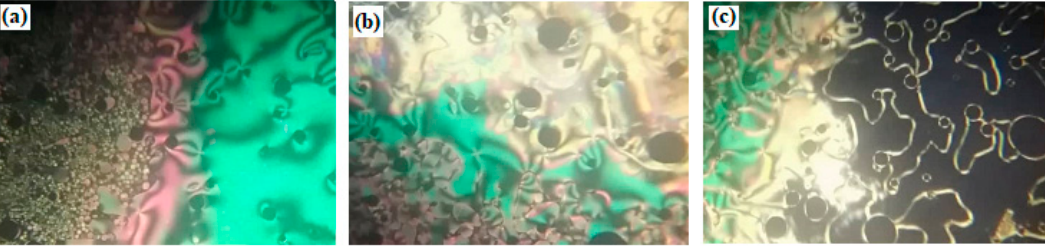
Figure 3. Nematic phase textures during heating under polarized optical microscopy (POM) of 1:2 HBSMC, A/2B12 ( a ) at 83.0 °C, ( b ) at 91.0 °C, and ( c ) at 95.0 °C.